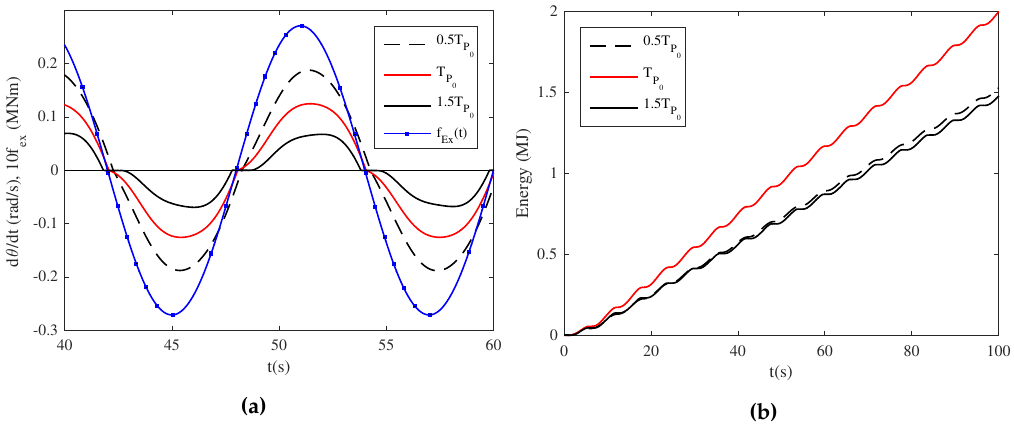
Figure 13. ( a ) Phase difference of f Ex vs. ˙ θ and ( b ) Cumulative energy capture for different loads with